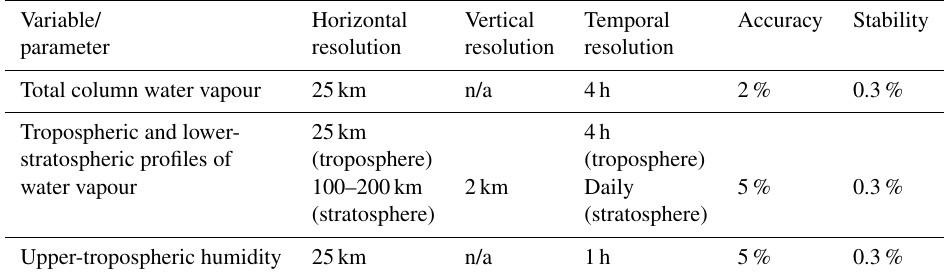
Table 1. GCOS target requirements for the satellite-based essential climate variable (ECV) of water vapour (WMO GCOS, 2011). Variable/ Horizontal Vertical Temporal Accuracy